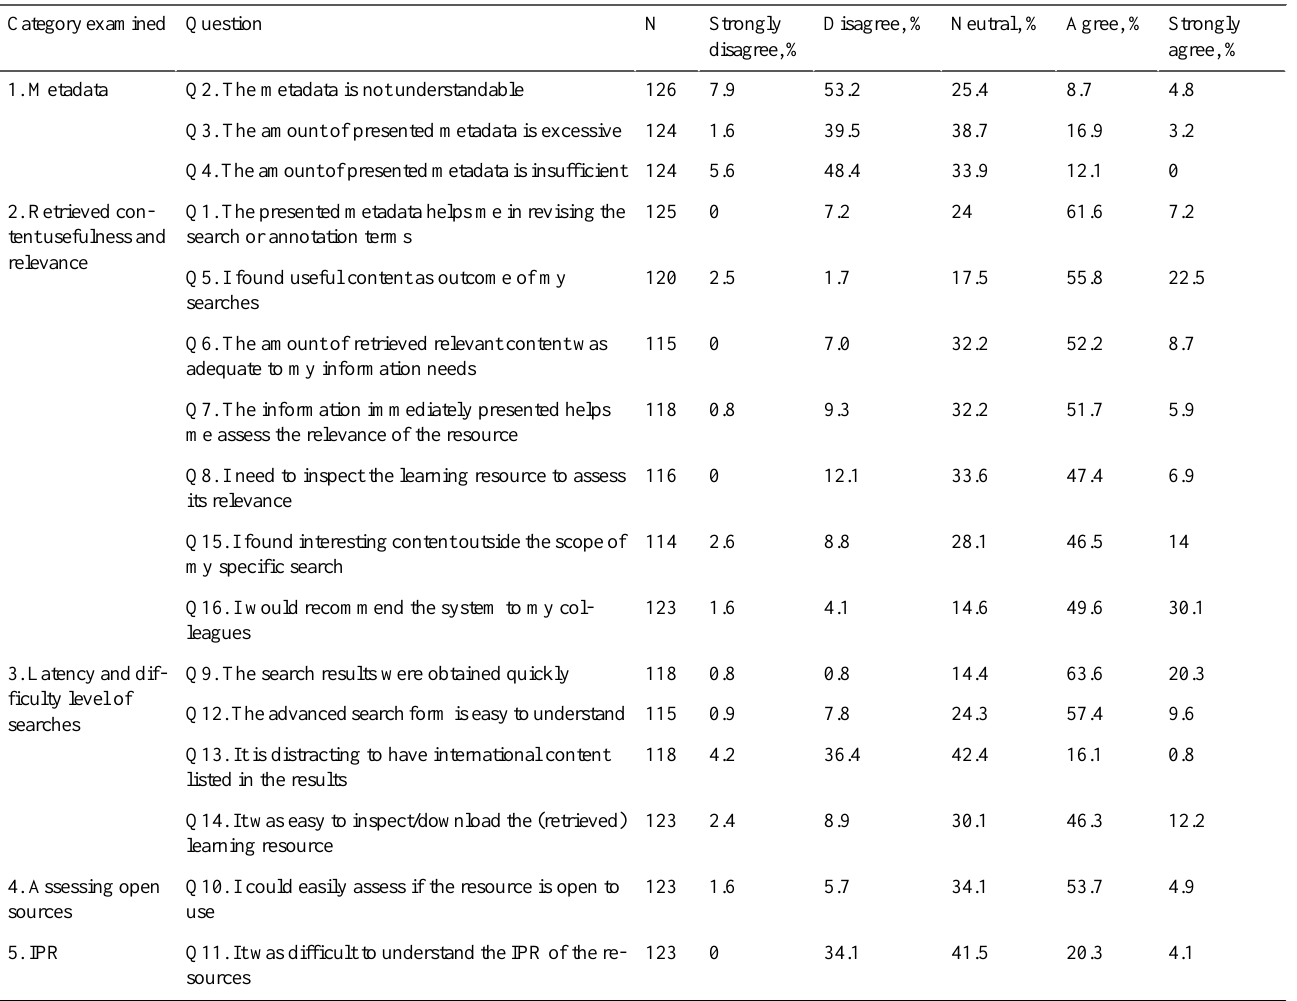
Table 2. Results for the evaluation of the metadata and search process (N=126).